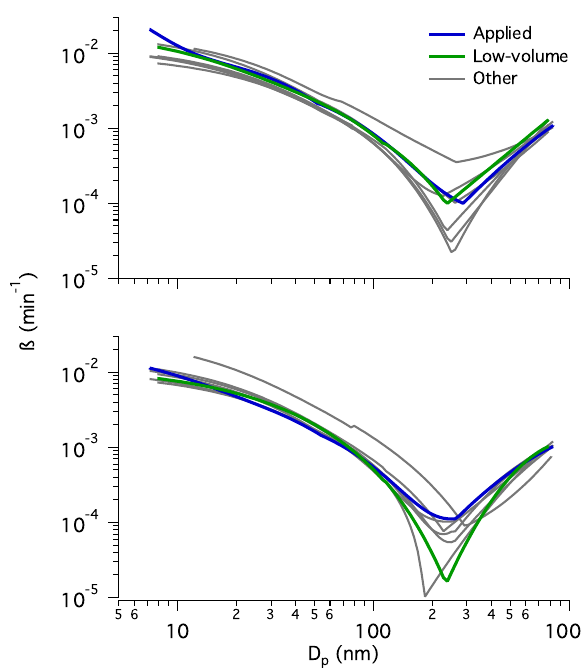
Fig. 1. Particle wall loss rates, β , measured in both chambers from September 2009 to August 2011. The top panel corresponds to near chamber, and the bottom panel corresponds to far chamber. The wall loss rates labeled “applied” were applied to the experiments re- ported in this manuscript. The wall loss rates labeled “low-volume” were calculated during a wall loss calibration experiment in which the initial chamber volume was decreased by 8m 3 to simulate con- ditions achieved after 18 h of sampling. The wall loss rates labeled “other” are those calculated from quarterly calibration